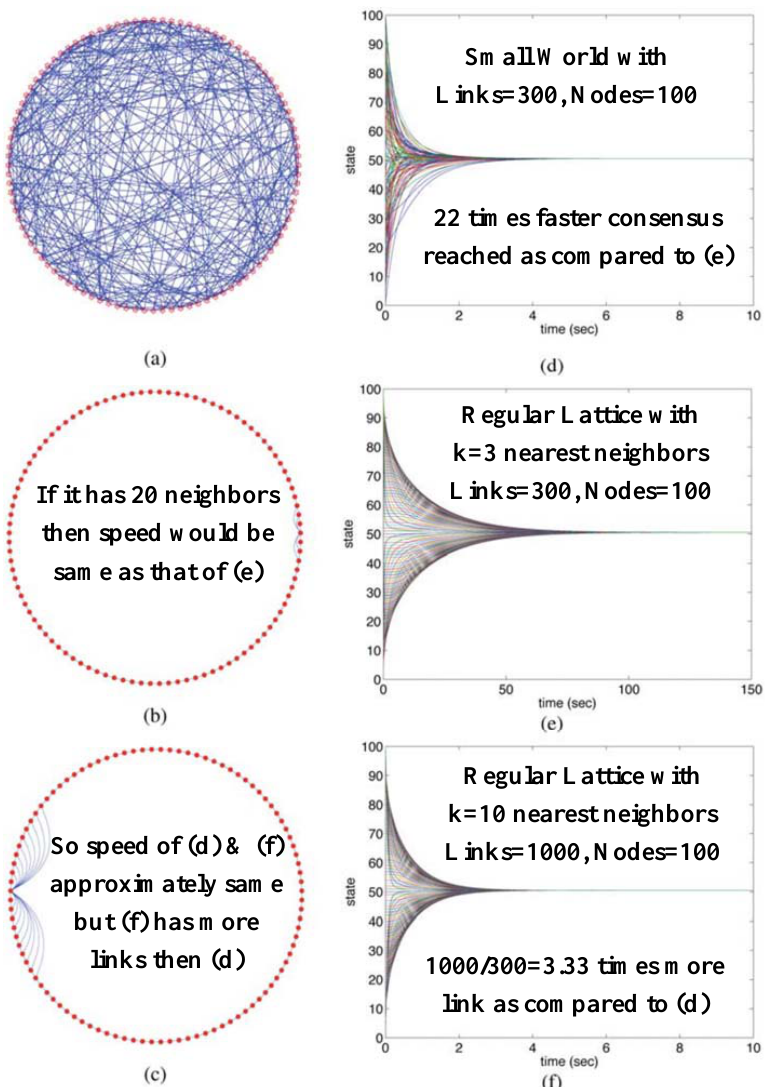
Figure 6. Consensus Algorithm for 3 different networks [47]. ( a ) Small ‐ world with 300 links and 100 nodes ( b ) A regular lattice with k=3 nearest neighbors, 300 links and 100 nodes ( c ) A regular lattice with k=3 nearest neighbors, 300 links and 100 nodes ( d ) State evolution of part ‐ a ( e ) State evolution of part ‐ b ( f ) State evolution of part ‐ c.